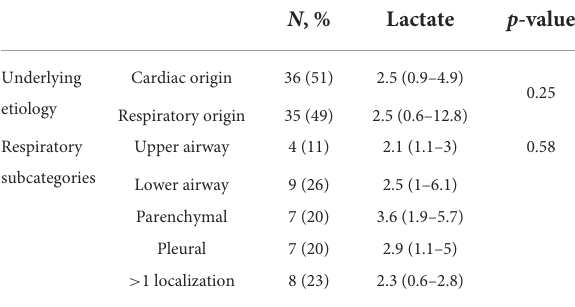
TABLE 4 Prognostic value of admission lactate concentration in cats presented with respiratory distress to predict underlying etiology of respiratory distress (cardiac vs.